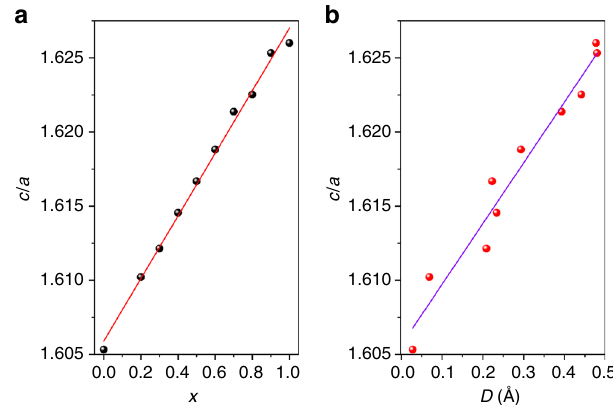
Fig. 6 Evolution of c/a values. Plots of c / a values against a the doping Pb content and b the stereochemical lone pair activity (average displacements for Ba 2 + /Pb 2 + cations) in CaBa 1 − x Pb x Zn 2 Ga 2 O 7 . For x = 0, 0.5, and 1, the parameters are obtained from combined Rietveld re fi nement against both XRD and ND data. Source data are provided as a Source Data fi